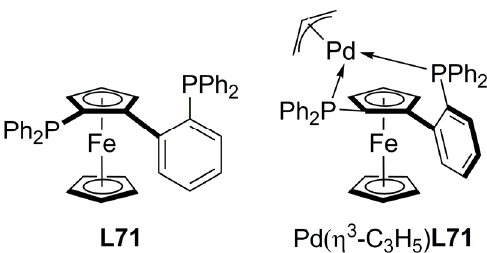
Figure 26. Knochel’s novel diphosphine